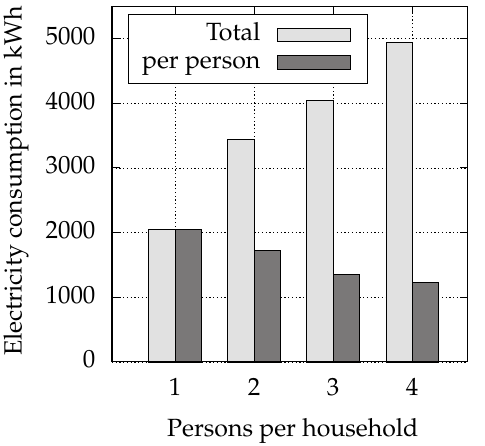
Figure A1. Average electricity consumption by household size (Authors own compilation based on